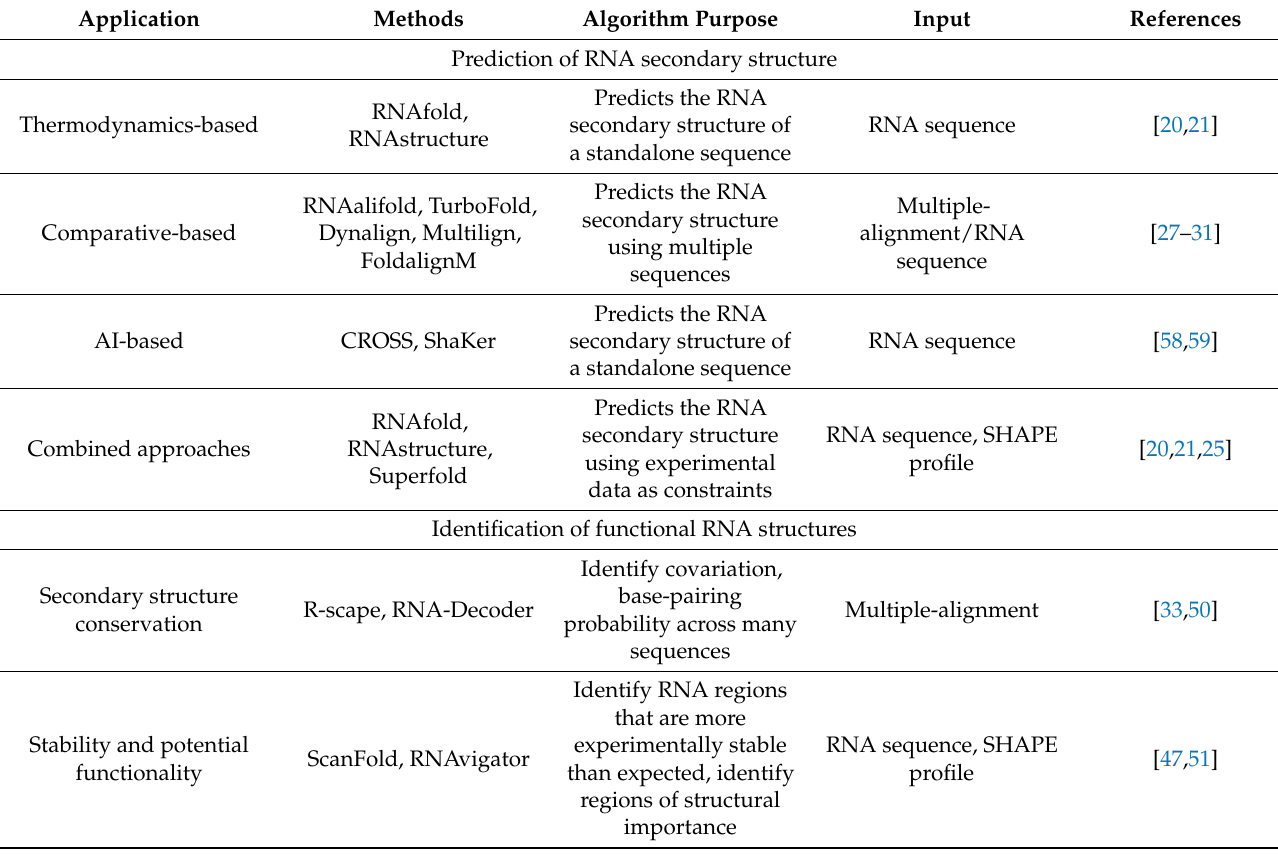
Table 1. Algorithms to predict and study RNA secondary